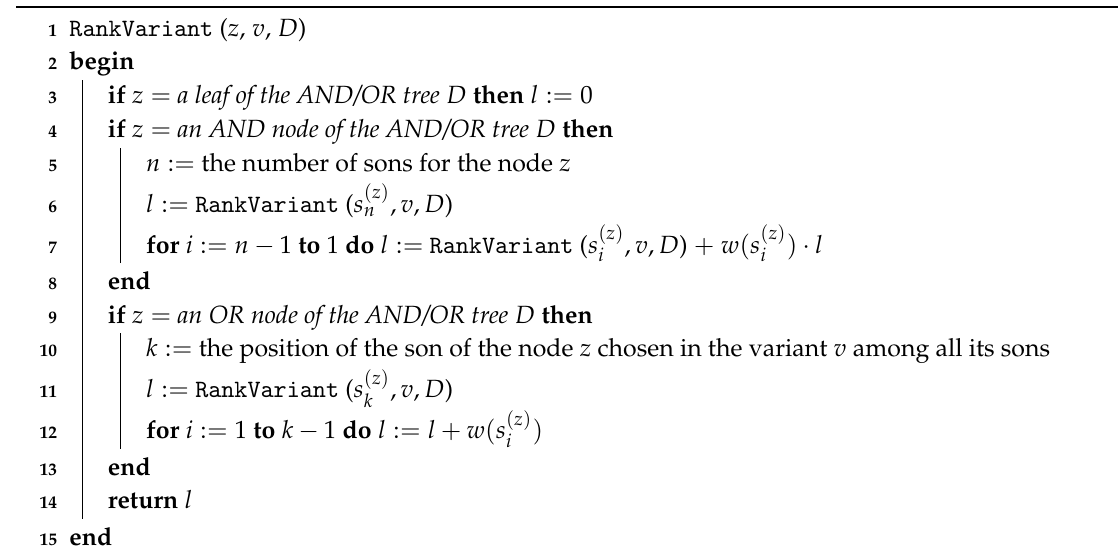
Algorithm 1: A general algorithm for ranking the variants of an AND/OR